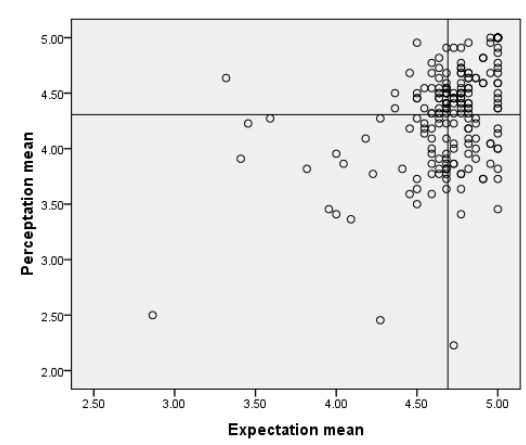
Figure 3. Scatter plot for perception mean vs. expectation mean for all